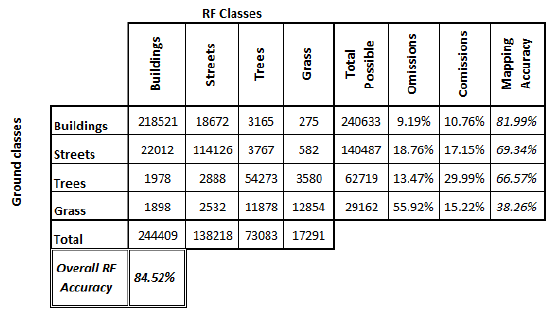
Table 1. Example of the confusion matrix for 9x9 pixel neighborhood, T = 50 , D = 15, GRAZ dataset